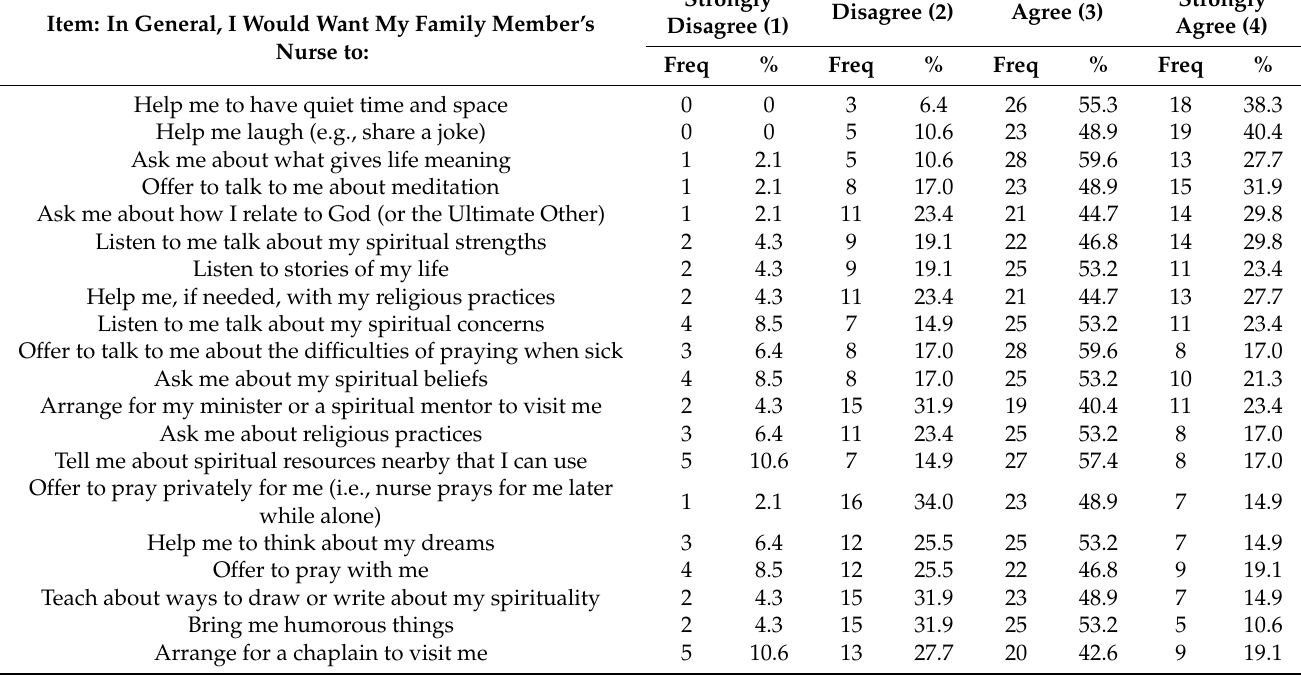
Table 2. Description of family members’ responses to the NSTS ( n = 47). (Frequencies (Freq),